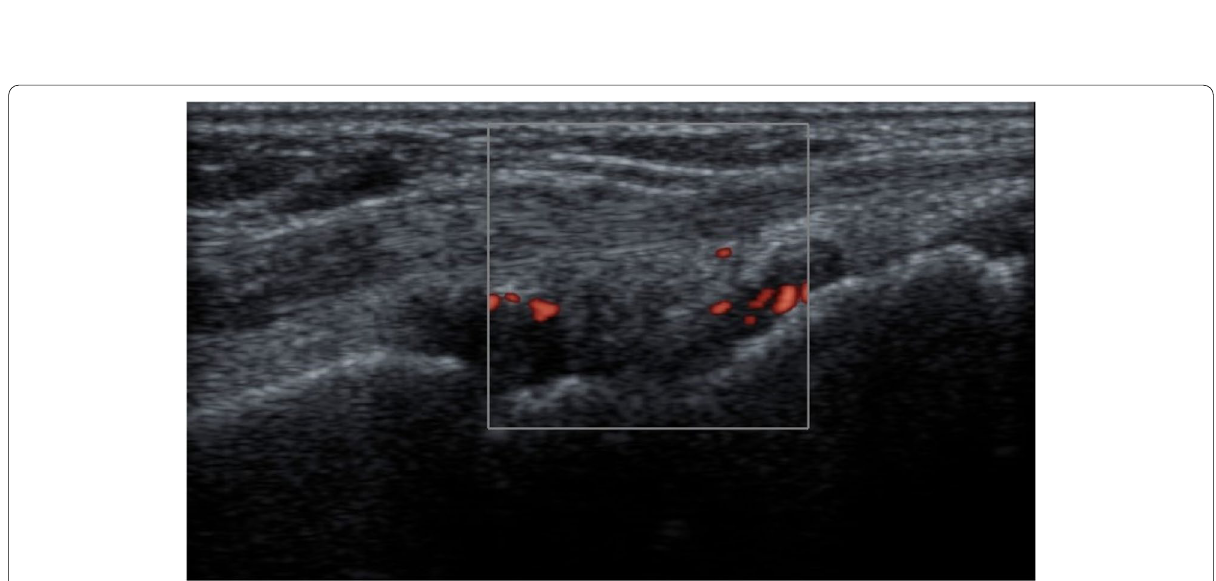
Fig. 2 PDUS dorsal longitudinal scan showing grade II Doppler activity in wrist